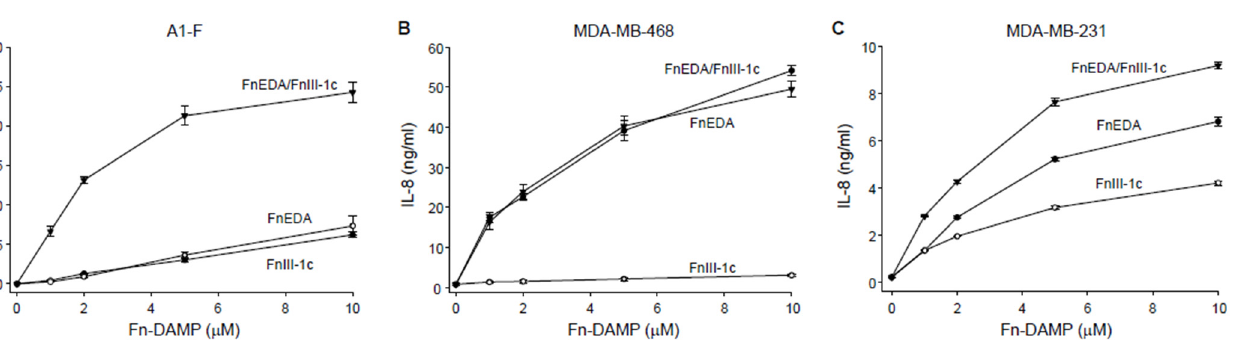
Figure 1. FnEDA and FnIII-1c stimulate IL-8 synthesis in human dermal fibroblast and triple-negative breast cancer cells in a dose-dependent manner. ( A ) Human dermal fibroblasts (A1-F) and triple-negative breast cancer cells, ( B ) MDA-MB-468, and ( C ) MDA-MB-231 were treated with increasing concentrations of the fibronectin DAMP domains FnEDA or FnIII-1c alone or in combination for 4 h under serum-free conditions. Conditioned medium was collected after 4 h and IL-8 concentration determined by ELISA. IL-8 concentration shown represents the mean ± SEM of three independent experiments performed in triplicate.